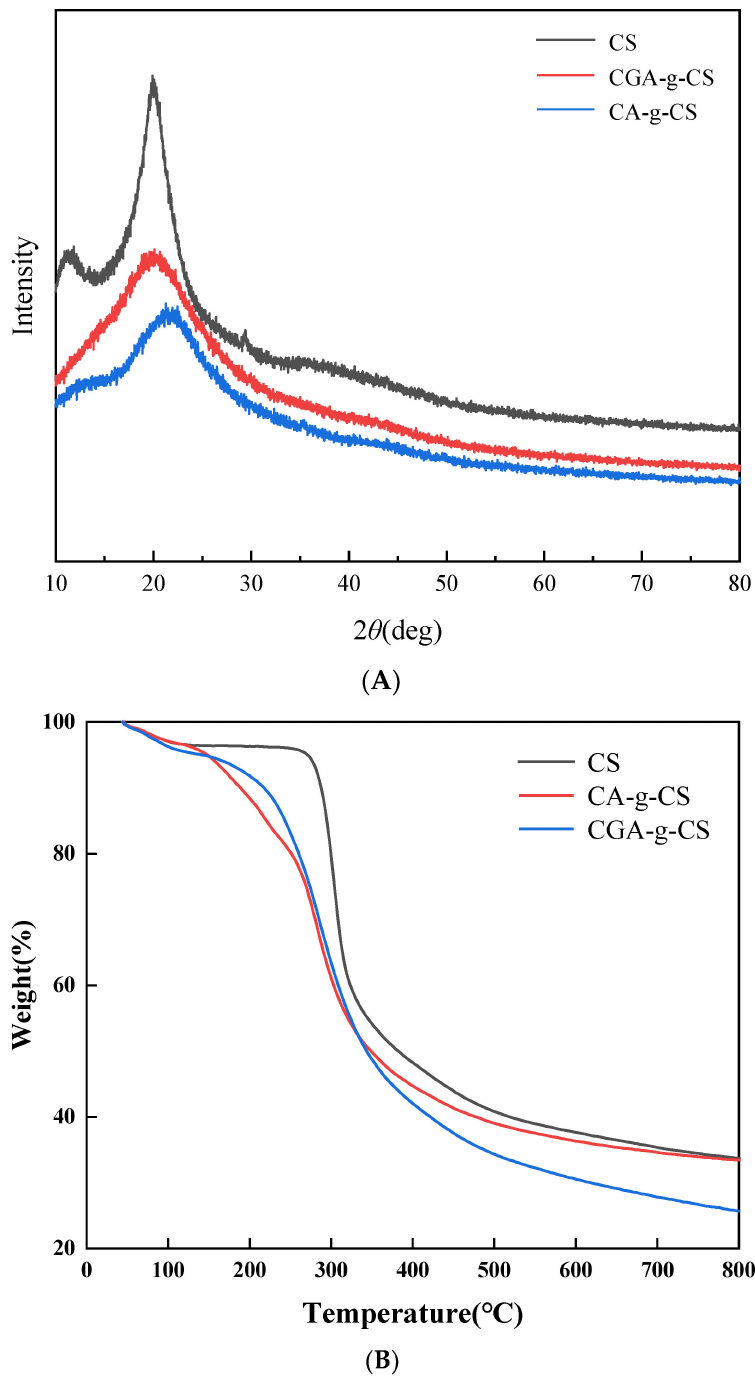
Figure 3. XRD spectra of CS and phenolic acid-CS ( A ); TGA curves of CS and phenolic acid-CS ( B